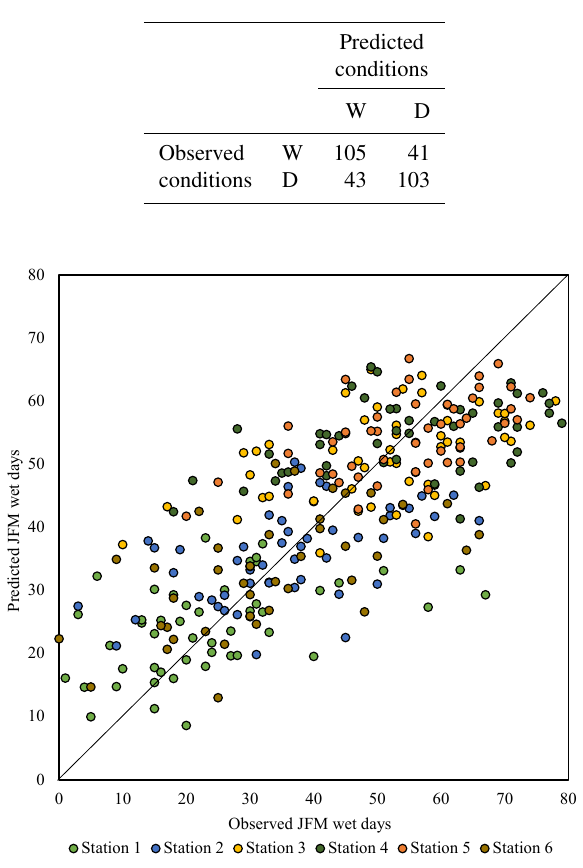
Table 5. Hit–miss matrix for model predictions of years with above- average (W) and below-average (D) numbers of wet days.